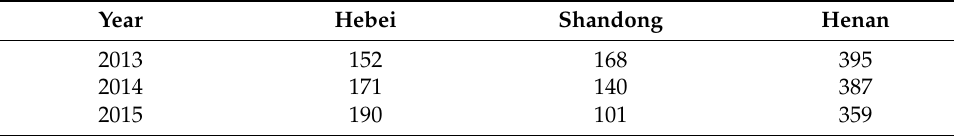
Table A1. The number of sample farms.